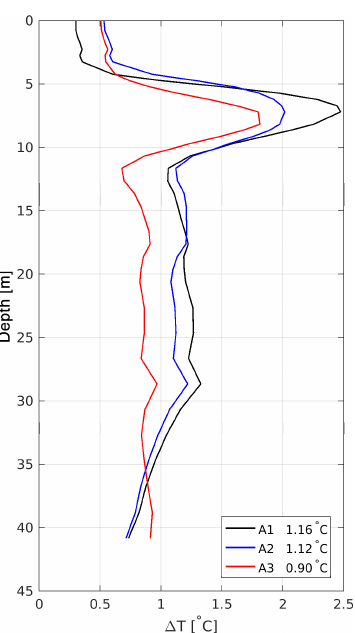
Figure 9. ROMS runs A1, A2, and A3: the rms temperature dif- ferences (cid:49)T [ ◦ C] between the modelled temperature T ROMS and the observed temperature T obs evaluated at the actual depths of the observations. The vertical mean (cid:49)T is written in the second col- umn of the legend box. (cid:49)T was computed only for the period after 15 June at